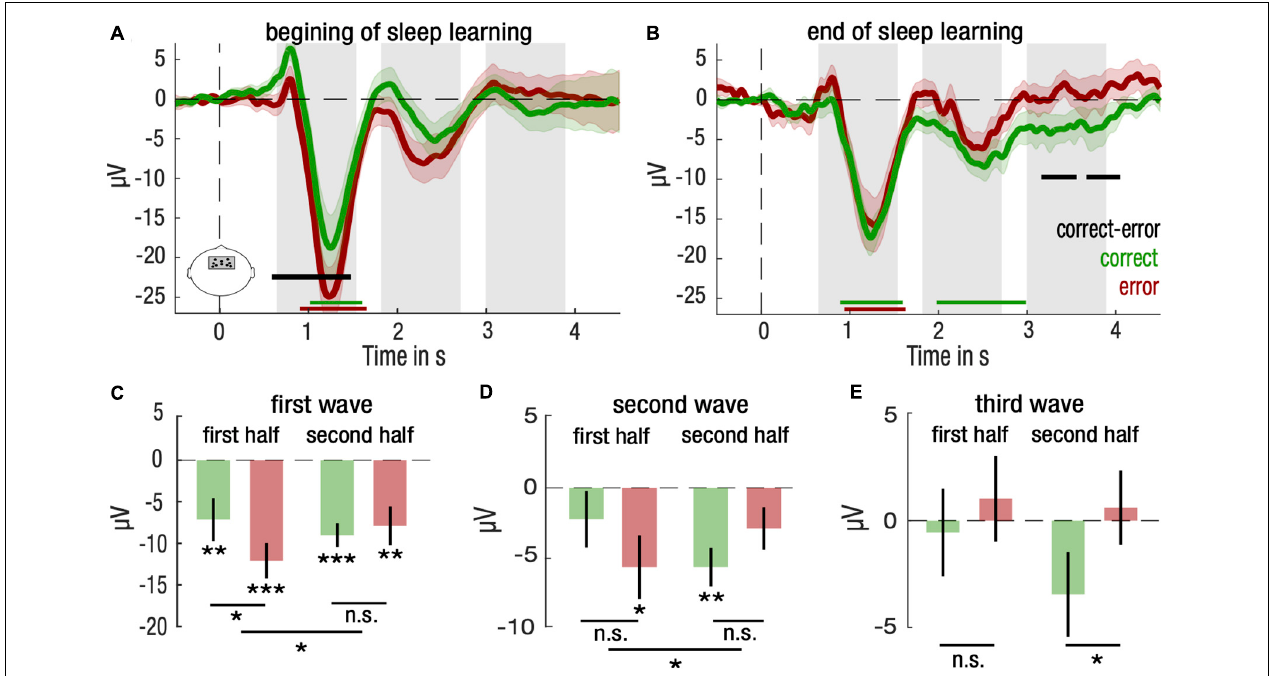
FIGURE 4 | Differential entrainment of frontal neural responses to stimulation for correctly and incorrectly identified items for the first half and the second half of NREM trials. (A,B) Mean and standard error of the mean (SEM) are represented, respectively, with solid lines and shaded areas for the correct (green) and the error (red) trials for the first (A) and second (B) half trials in NREM sleep. Green, red and black horizontal lines denote significant clusters of neural responses differing from baseline (0, dotted line) for, respectively, correct trials, error trials, or the difference between both conditions ( P < 0.05 after cluster correction). Gray bars indicate time clusters spanning over the three-fourth of a slow wave rhythm at 0.85 Hz centered over its trough. (C–E) Neural responses for correct (green) and error (red) trials for the first and second half of trials were averaged and compared for the first (C) , second (D) and third (E) slow wave. Mean and standard error of the mean (SEM) are represented, respectively, with bar plots and solid lines. Student’s T -test against baseline (0, dotted line) was computed for correct and error trials and corrected for multiple comparisons. Paired Student’s T -test were computed between correct and error trials for and corrected for multiple comparisons. Interaction between trial type (correct vs. error) and period of the night (first vs. second half) for each slow wave was computed with repeated measures ANOVA (*** P < 0.001, ** P < 0.01, * P < 0.05).